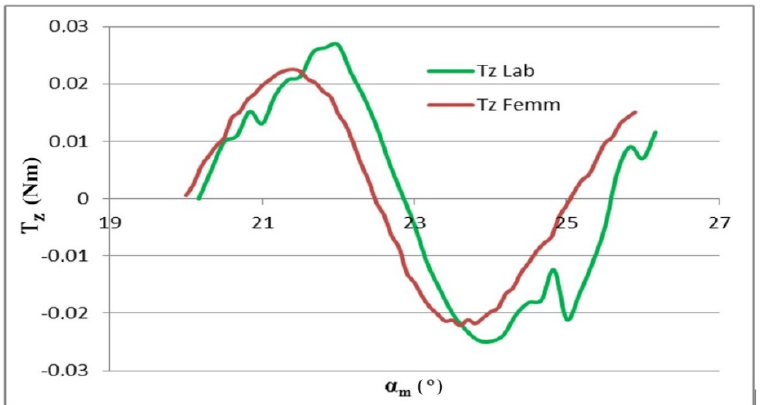
Figure 12. Comparison of cogging torques in the laboratory DCPM motor and the simulation DCPM motor.